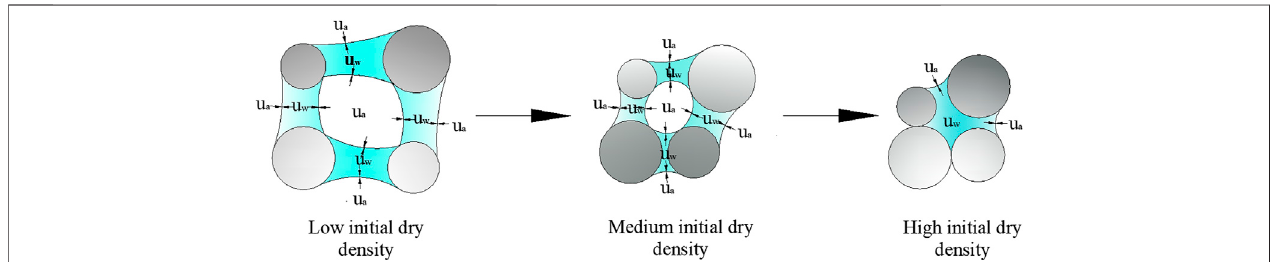
FIGURE 10 | Meniscus forces between tailings particles at different initial dry